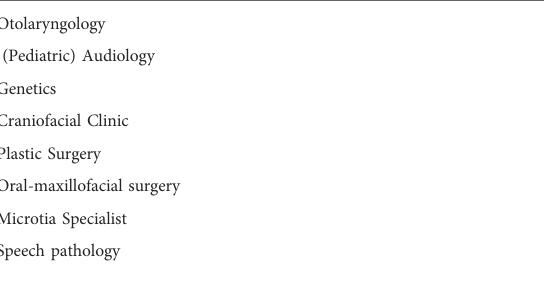
TABLE 2 Consultations to consider for newborn/child with microtia and atresia. Consultations to consider for newborn/child with microtia and